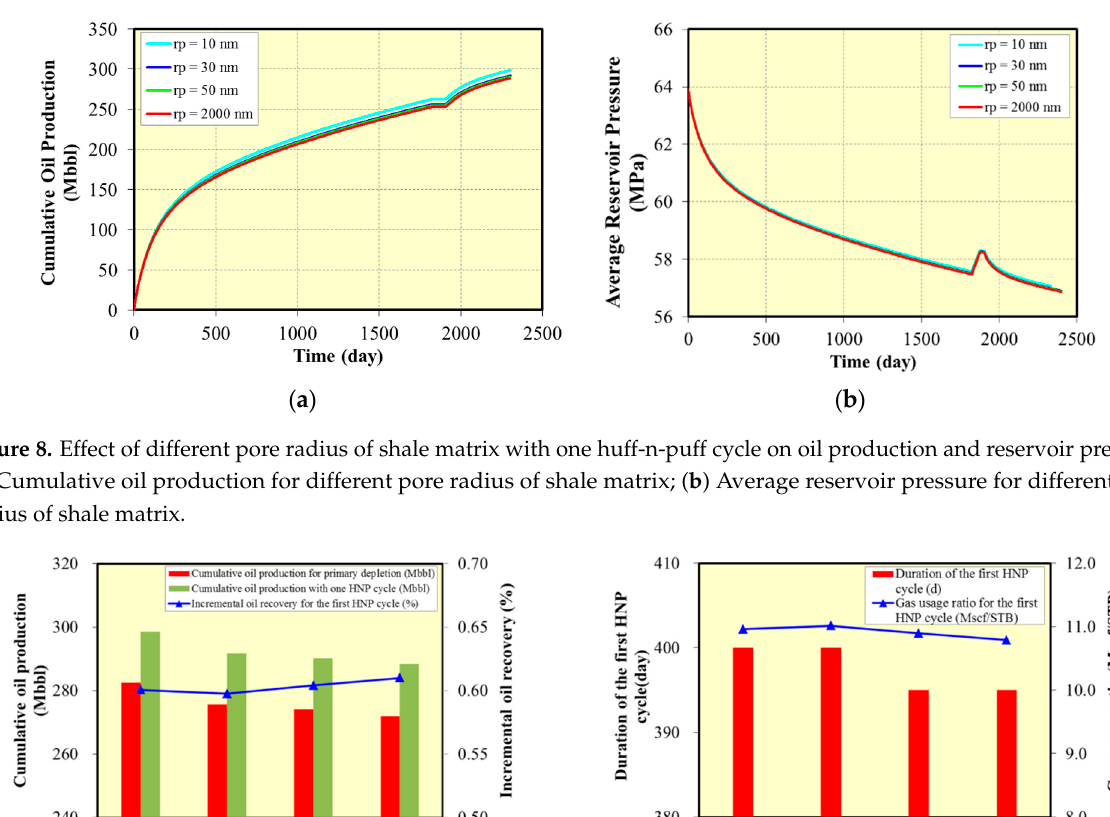
Figure 9. Correlation between pore radius of shale matrix and huff-n-puff results: ( a ) Cumulative oil production and in- cremental oil recovery for different pore radius of shale matrix; ( b ) Duration of the first huff-n-puff cycle and gas usage ratio for different pore radius of shale matrix.